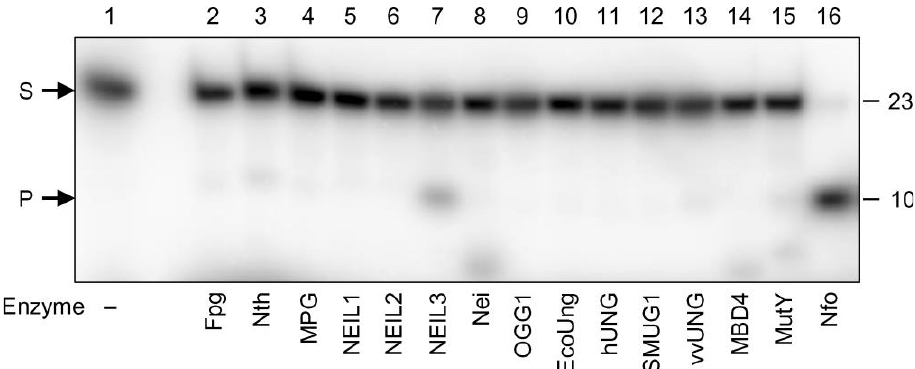
Figure 6. Resistance of EAP to DNA glycosylases. A representative gel illustrating the reaction of EAP with double-stranded DNA (EAP:C) is shown. The nature of the enzymes is indicated below the gel image. Arrows indicate: S, 23-mer substrate; P, 10-mer product.